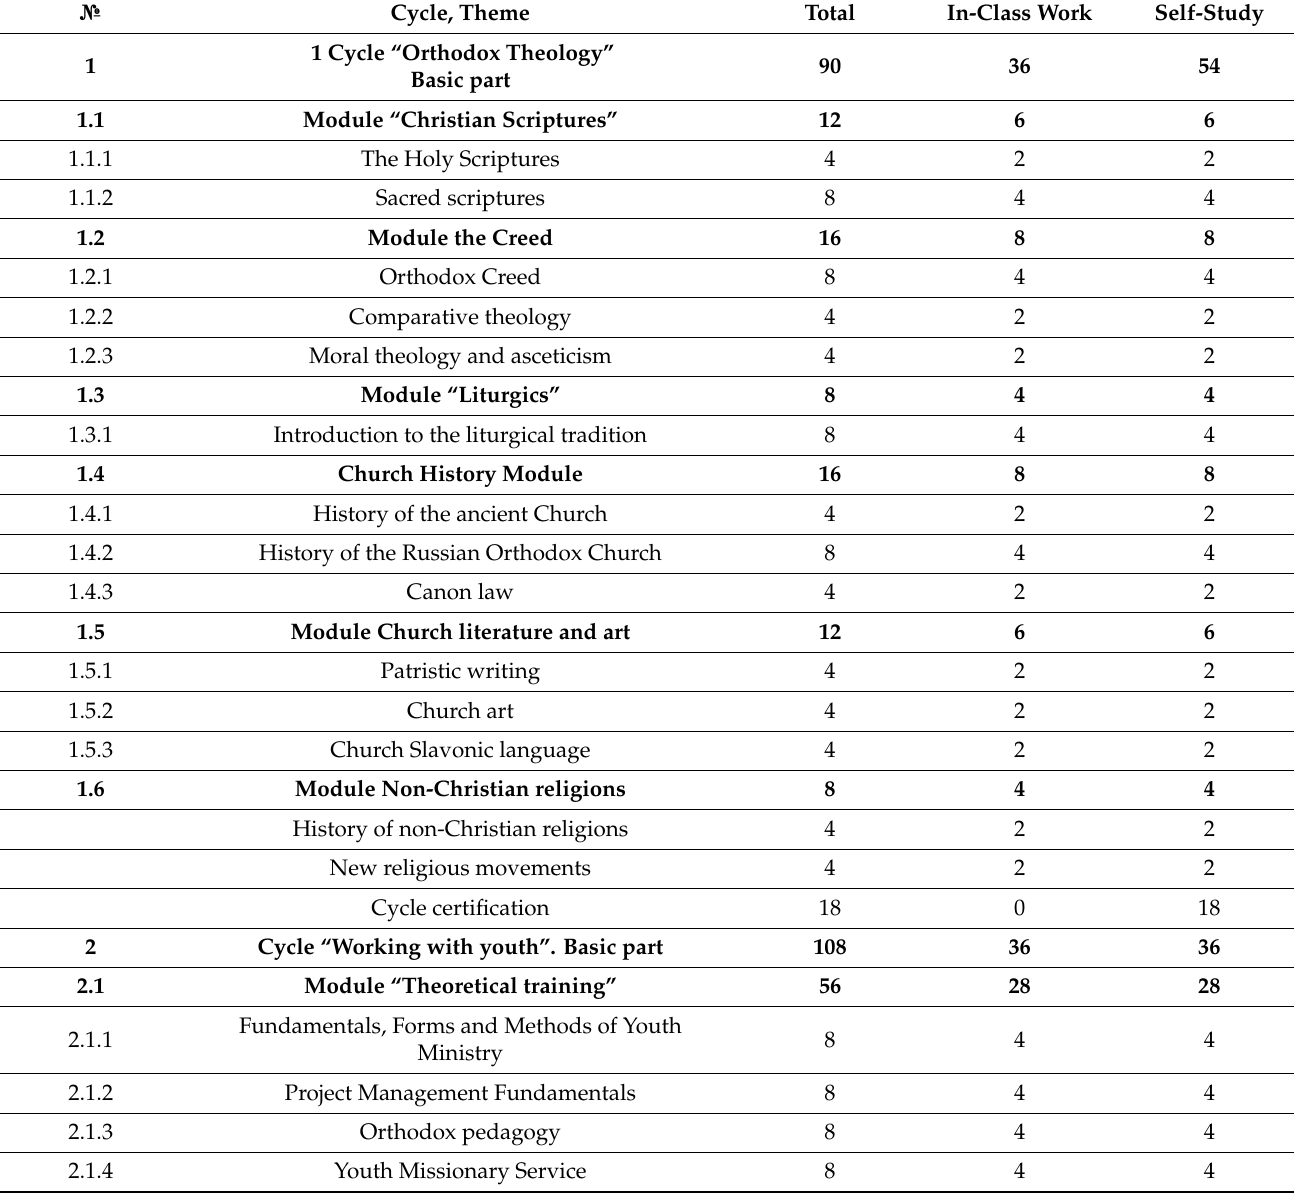
Table 1. Sample curriculum short training courses for Staff Assistant Rector (deanery) at youth ministry